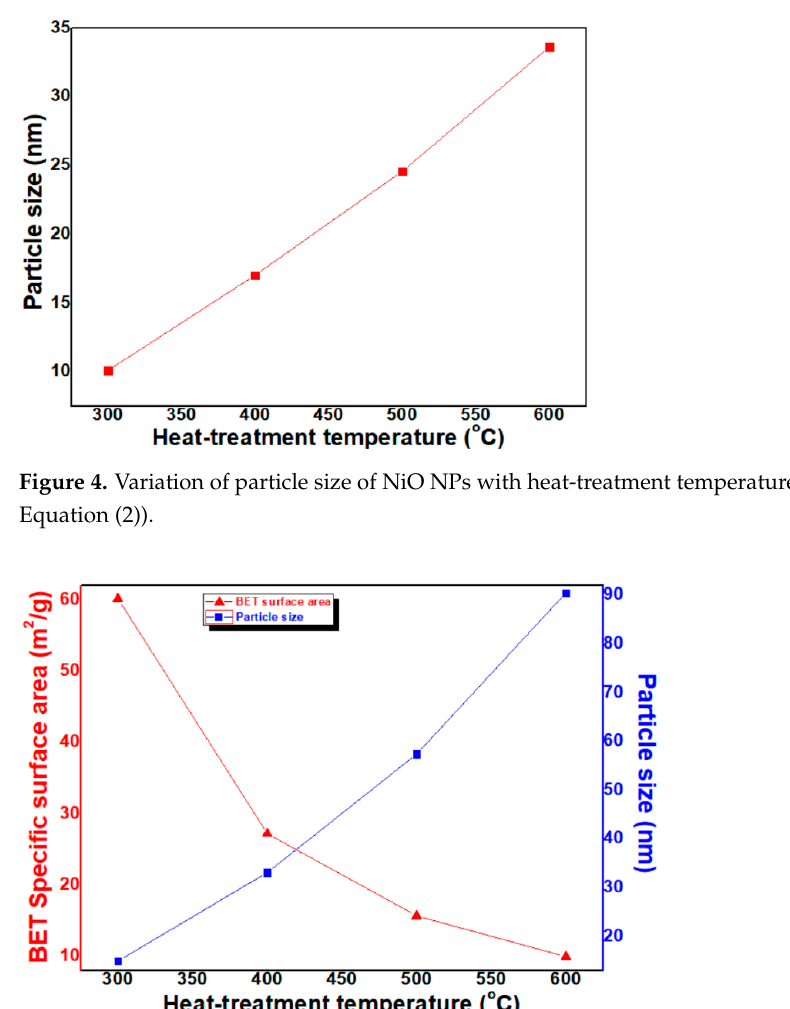
Figure 5. Variation of BET SSA and particle size (calculated by using Equation (3)) of NiO NPs with heat-treatment temperature.